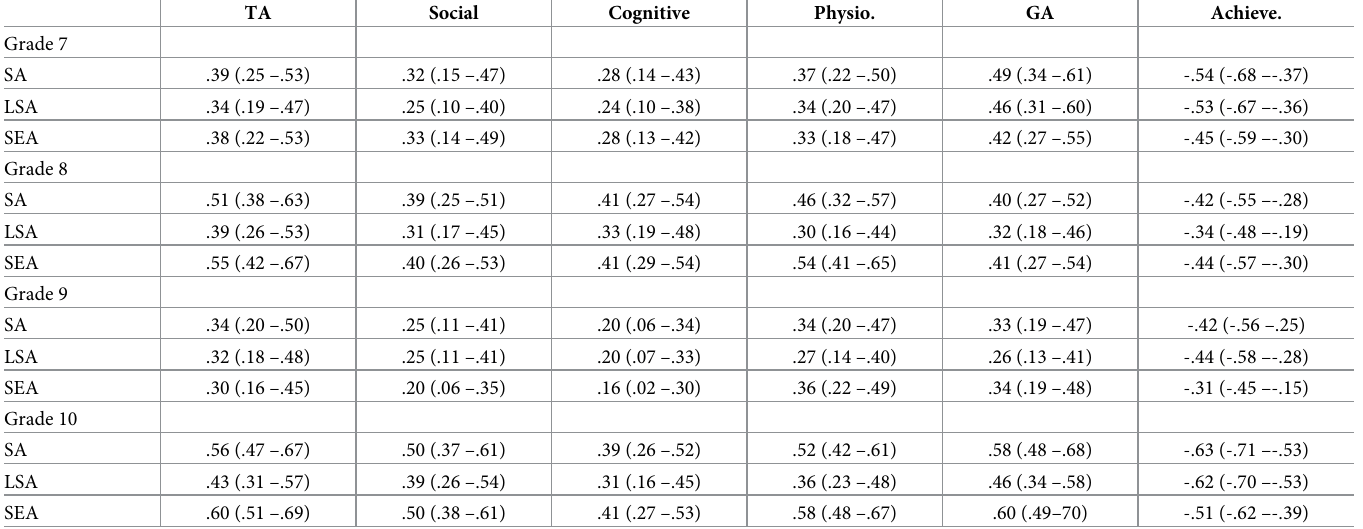
Table 3. The correlations among the three anxiety scales in Study 1.